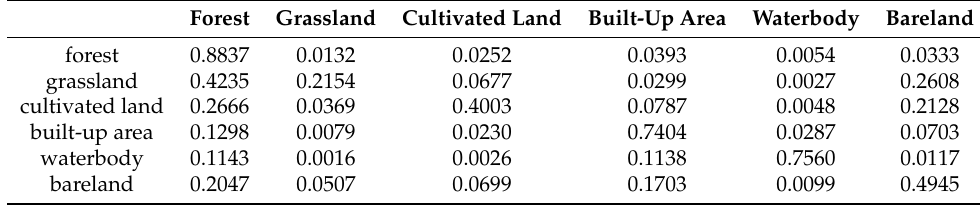
Table 2. The classification confusion matrix of Shenzhen in 2015 using the diffusion equation. Forest Grassland Cultivated Land Built-Up Area